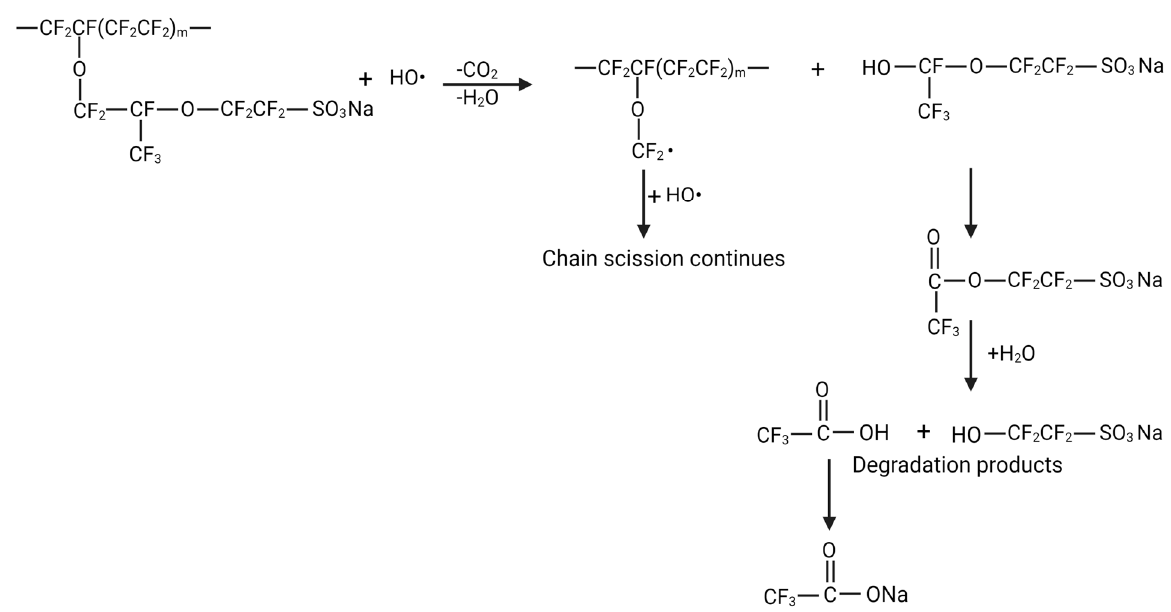
Figure 9. S chematic of the side chain scission process. Figure 9. Schematic of the side chain scission